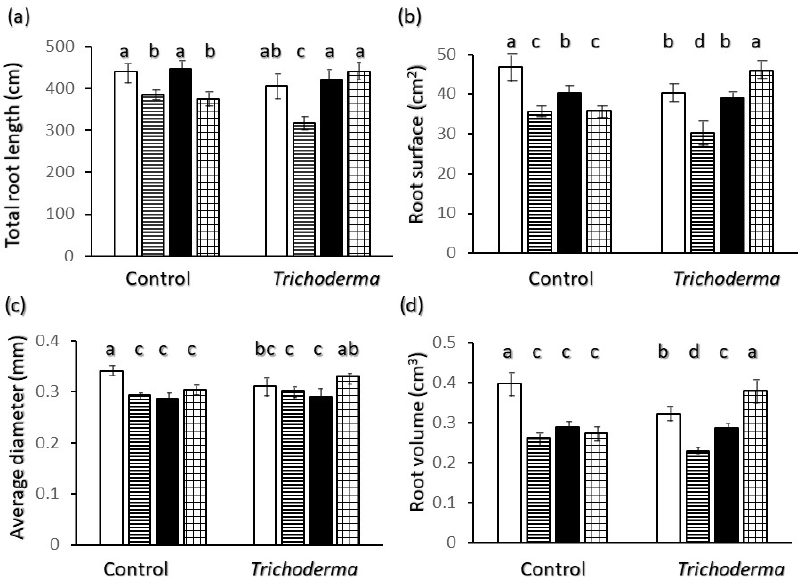
Figure 2. Interaction of wheat variety x Trichoderma harzianum T-22 inoculation on root biometrics: ( a ) total length of root structures; ( b ) root surface; ( c ) average diameter; ( d ) root volume. Color code of bars: white = Ciclope; horizontal stripes = Creso; black = Saragolle; grid = Simeto. Vertical segments on each bar indicate standard deviation n = 3. Different letters on each bar designate significantly different values for p < 0.05 at the Tukey’s post hoc mean separation test.